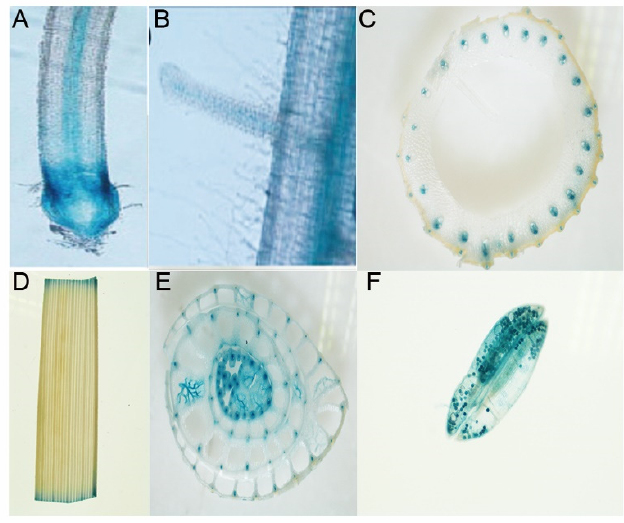
Figure 5. Organic expression pattern of OsCpn60 β 1 . Gus staining in axial root ( A ), lateral root ( B ), node ( C ), leaf ( D ), cross section of leaf sheath ( E ), anther ( F ).